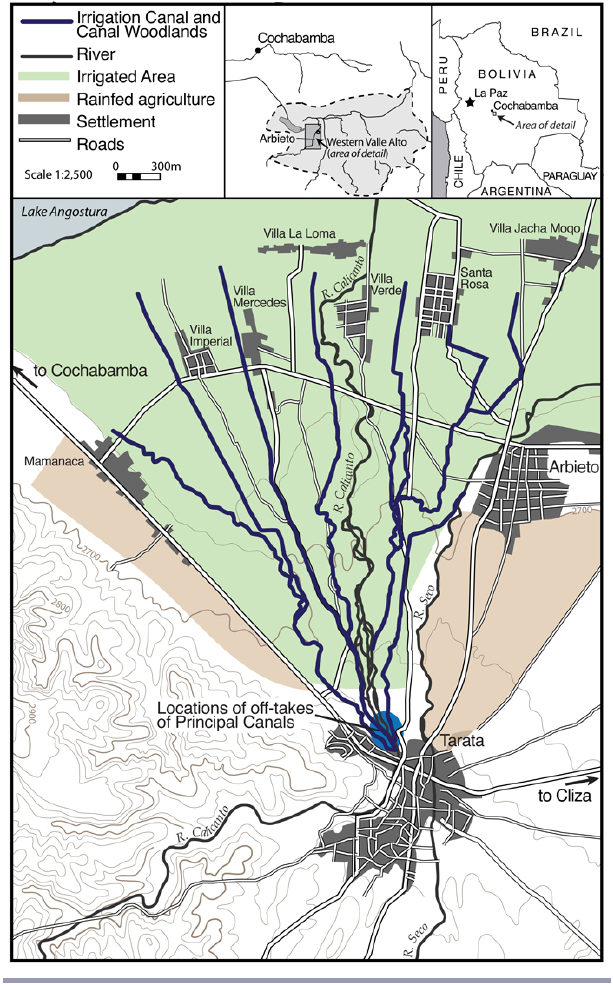
Fig. 3 . Geographic details of the Tarata-Arbieto cultural landscape of the western “High Valley” (Valle Alto), Cochabamba,